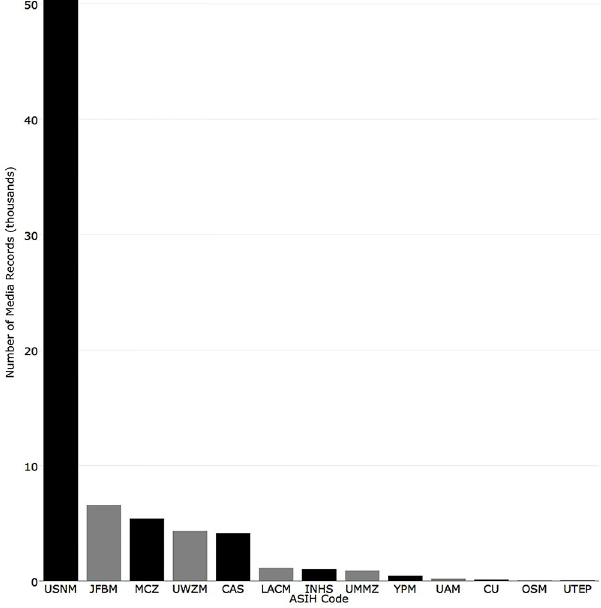
Fig 17. Number of media records associated with specimen records in